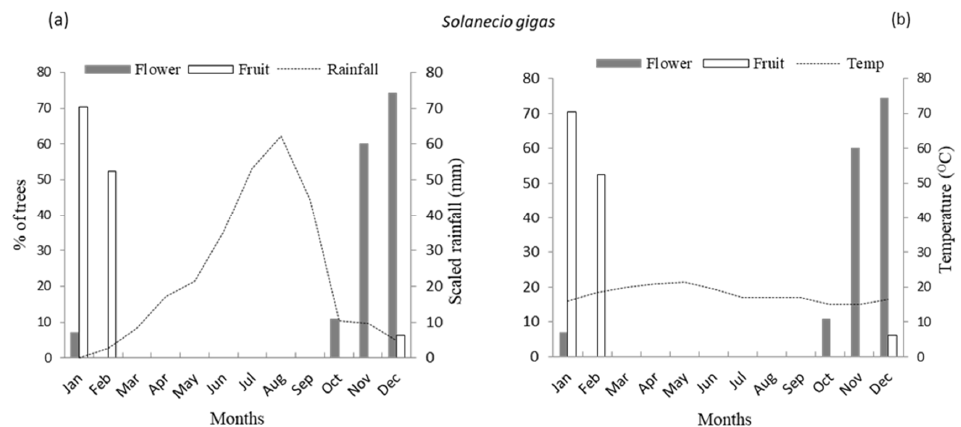
Figure 8. Percentage of flowering of Solanecio gigas and fruiting in relation to: ( a ) monthly precipitation and ( b ) average temperature. In which Jan = January, Feb = February, Mar = March, Apr =